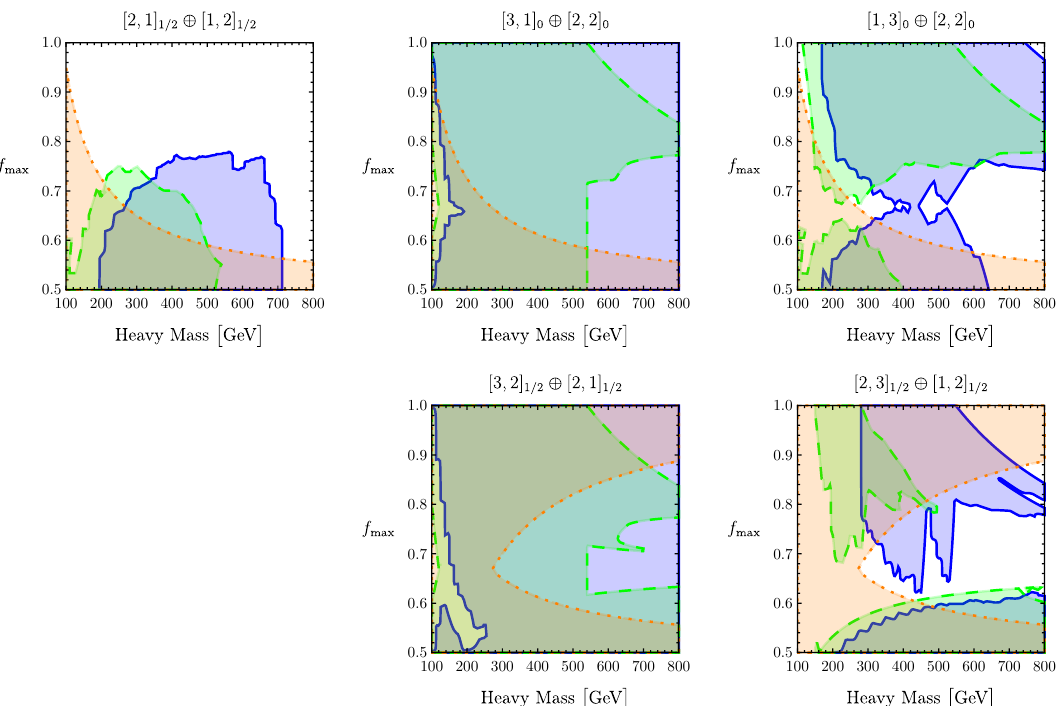
Figure 7 . Exclusions on fermionic Loryons from LHC searches for missing energy plus WZ (blue, solid) or WW (green, dashed) bosons, along with the LEP II bound (orange, dotted) on charged fermions, as a function of the mass of the heaviest fermions and the fraction f which is Higgs-dependent. Only combinations of custodial representations that remained viable after imposing the constraints in previous sections are